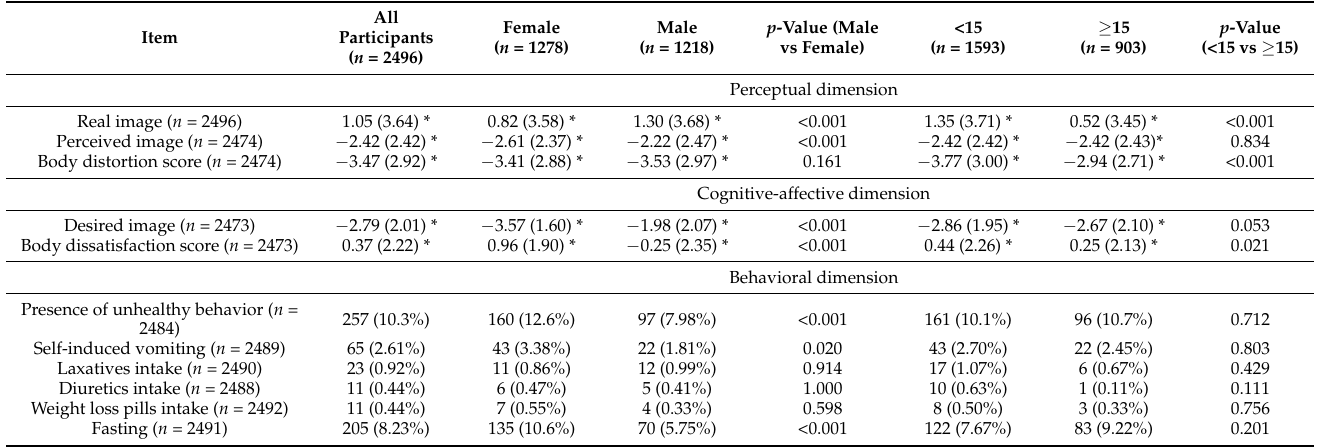
Table 2. Evaluation of the perceptual, cognitive affective and behavioral dimensions of the participants ( n = 2496).